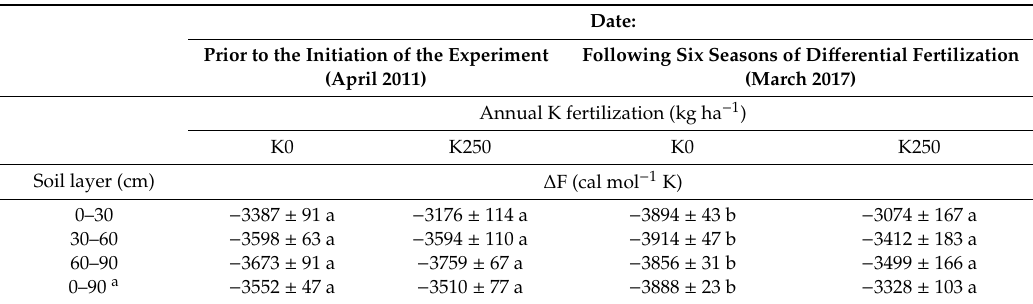
Table 5. The long-term e ff ect of K fertilization on ∆